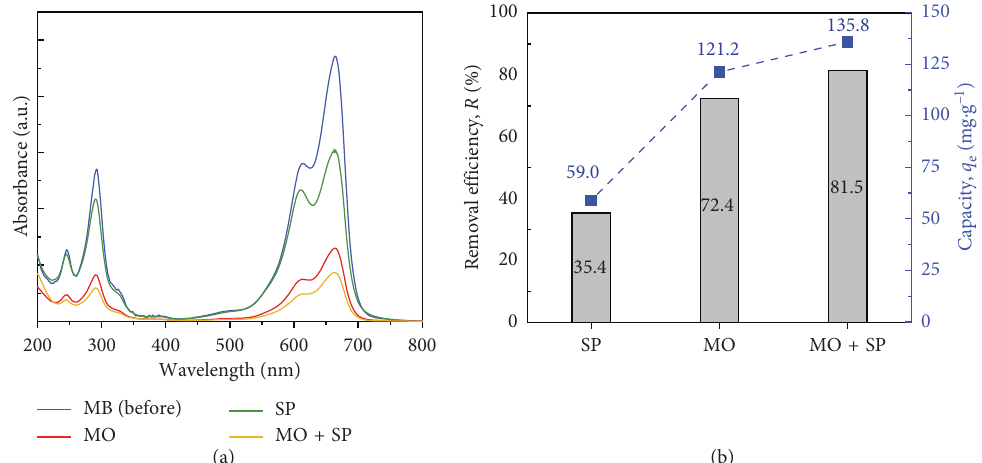
F IGURE 4: (a) UV-vis spectra for MB solution before and after treatment using adsorbent (MO), plasma (SP), and adsorbent/plasma (SP+MO) systems, respectively. (b) MB removal efficiency (gray bar) and capacity (-- ■ --) of each approach ( C 0 � 100mg L − 1 , 297K, contact or treatment time � 30min).